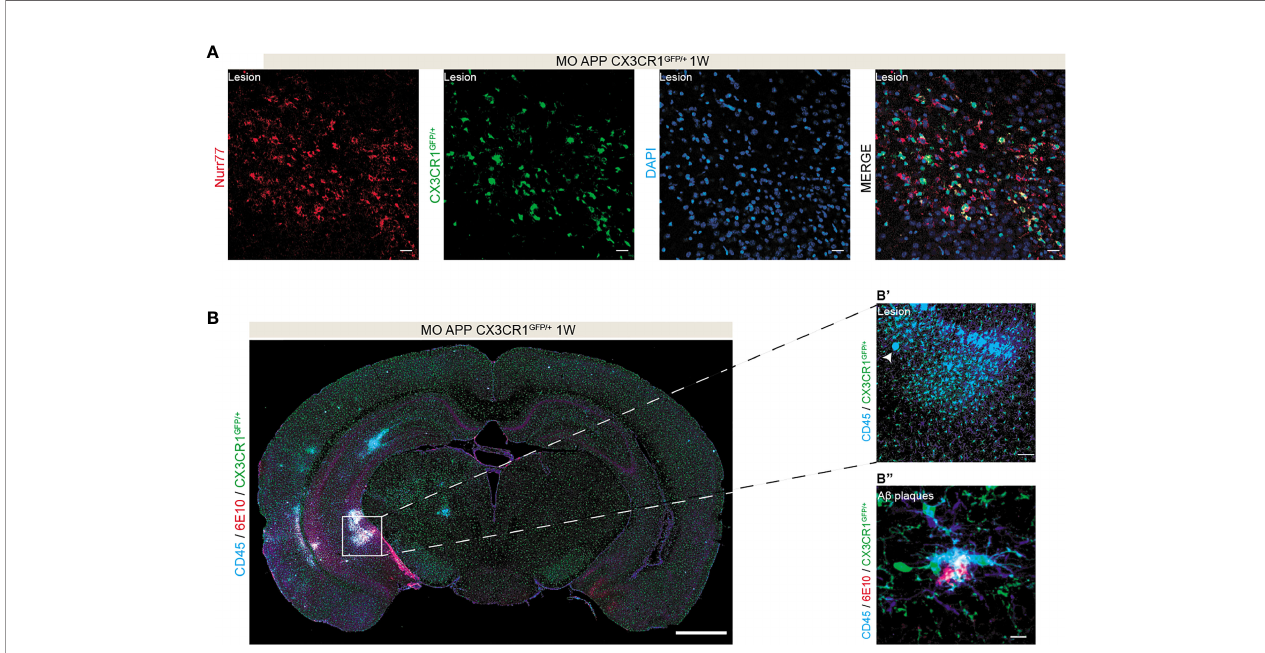
FIGURE 9 | In fi ltrated phagocytic monocytes are recruited to the lesion sites and A b plaques. (A) A tile representing a coronal brain section of MO-operated male APP/PS1/CX3CR1 GFP/+ mouse immunolabeled with CD45 (i.e. in fi ltrating cells, blue) and IBA1 (i.e. microglia; red) showing (A) the presence of CX3CR1 GFP/+ expressing Nurr77 + , highlighting their monocytic origin, at lesion site 1 week post-microinfarct induction. (B) A tile representing a coronal brain section of MO- operated male APP/PS1/CX3CR1 GFP/+ mouse immunolabeled with CD45 (blue) and 6E10 (A b plaques; red) showing (B ’ ) the presence of CD45 + /CX3CR1 GFP/+ cells at the lesion site and (B ’’ ) CD45 + /IBA1 + /CX3CR1 GFP/+ cells recruited to A b plaques. Scale bar = 20 µm (A) , 1000 µm (B) , 50 µm (B ’ ) and 25 µm (B ” )